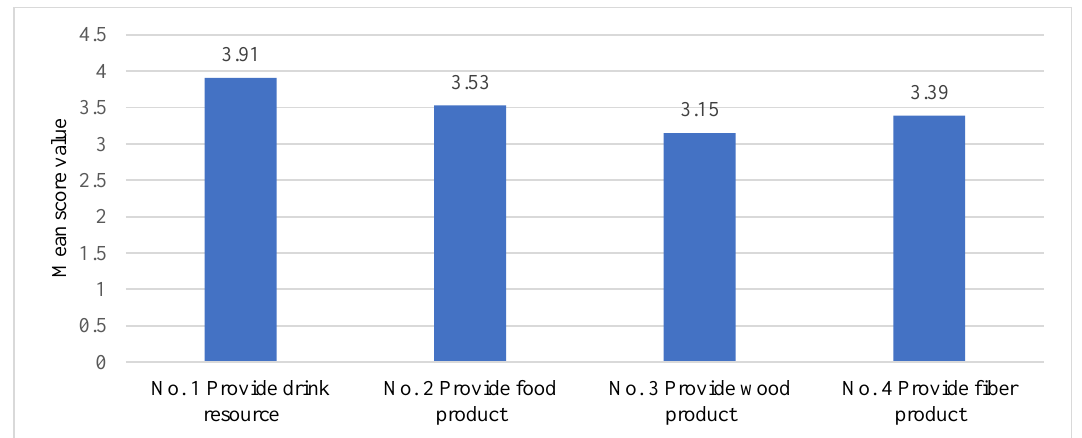
Figure 3. Provisioning services.